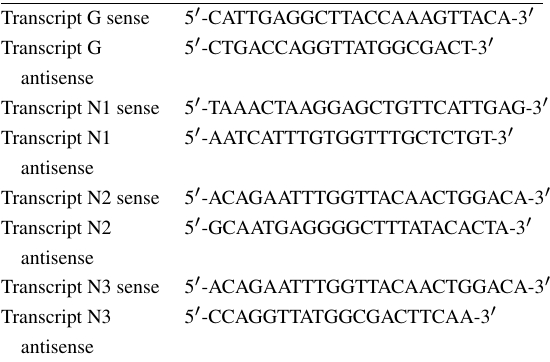
Primers used in the RT-PCR expression analysis of human IL-13Ra2 transcripts Transcript G